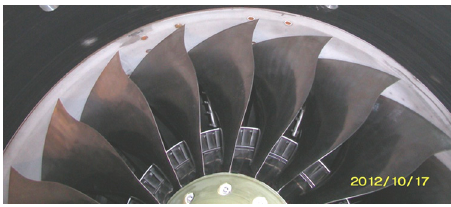
Figure 24. C180-2 model fan (a blade with a variable sweep and a forward swept tip).